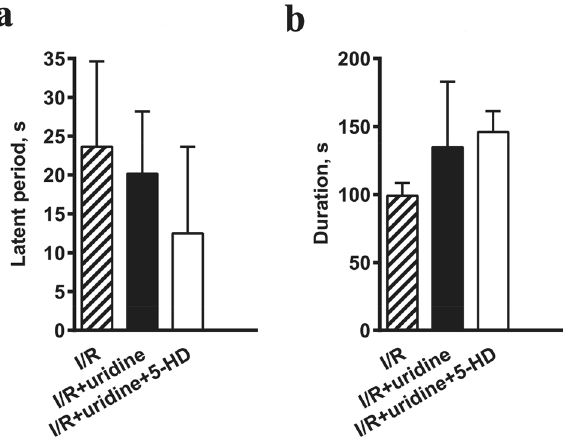
Figure 4. Effect of uridine on the onset of reperfusion-induced arrhythmias ( a ) and its duration ( b ). No statistical significance between I/R, I/R + uridine, and I/R + uridine + 5-HD groups was found.